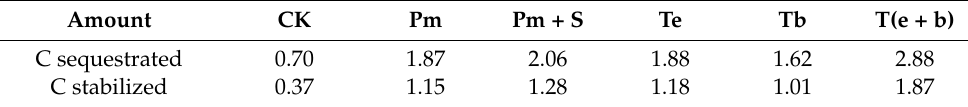
Table 3. Effects of the treatments on sequestrated and stabilized C stocks in soil after 4 years. Amount CK Pm Pm + S Te Tb T(e + b) C